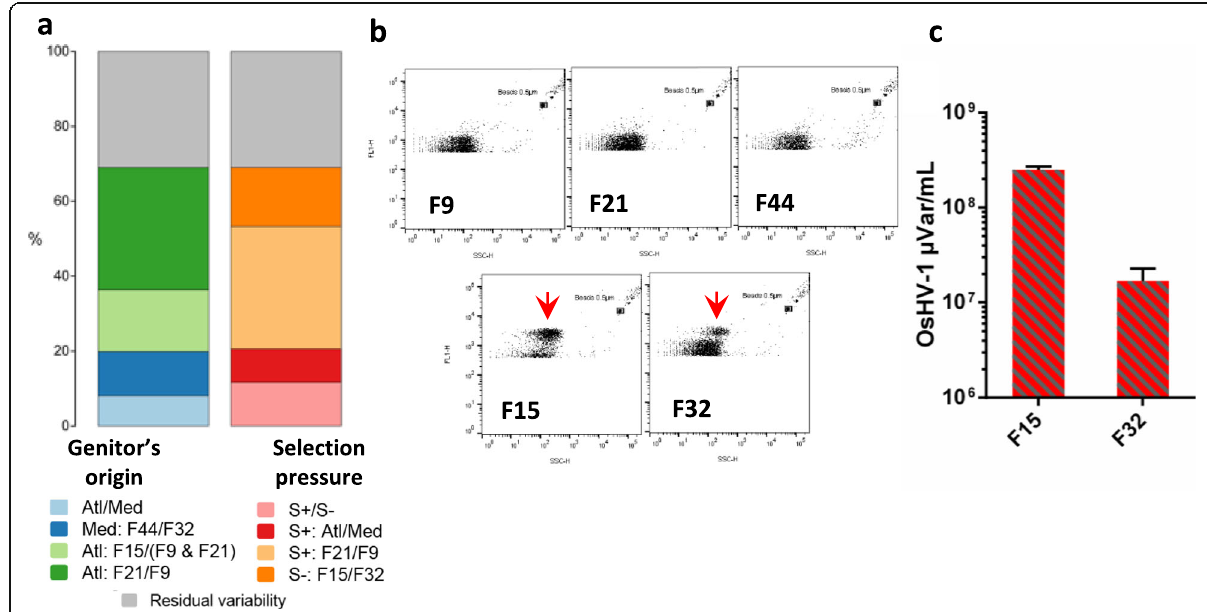
Fig. 7 Viral beta diversity and VLP load quantification in oyster hemolymphs during the infectious period. a Bar plots are graphical representations of Permanova results showing the amount of variation explained by families grouped by genitors ’ origin or selection pressure (for additional explanations see the legend to Fig. 4; table on which the barplots are based can be found in Additional File 13: Table S12). b Representative flow cytometry dot plots obtained for resistant (F9, F21 and F44) and susceptible (F15 and F32) families. For families F15 and F32, during the infectious period, we observed an additional VLP population characterized by a higher DNA content (red arrows). c) OsHV-1 μ Var loads in the oyster hemolymph of families F15 and F32 (mean ∓